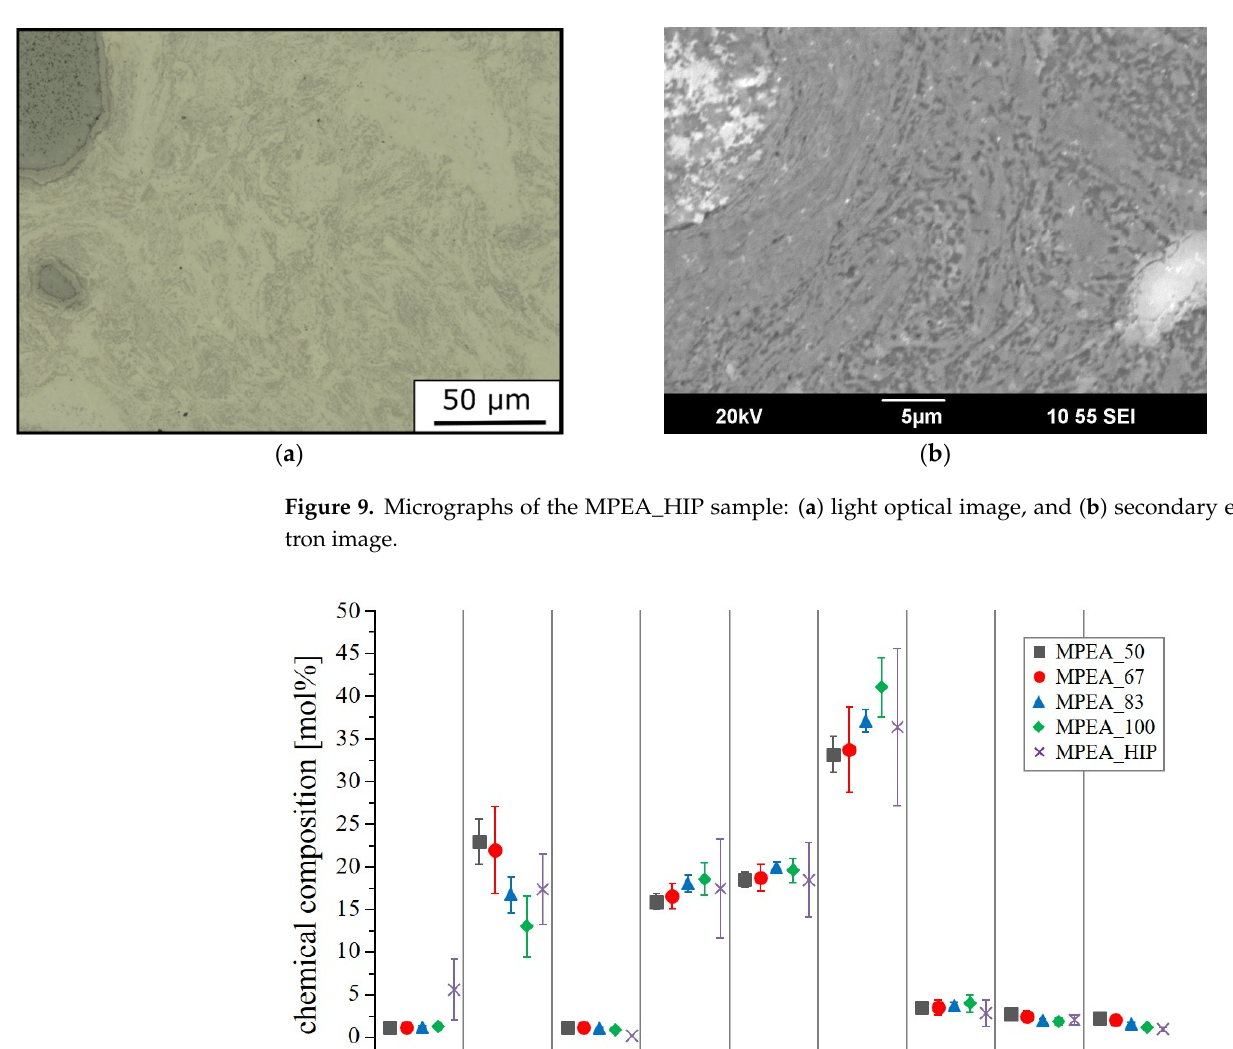
Figure 10. Average chemical composition of samples detected by EDS ‐ line scans within the steady ‐ state region.